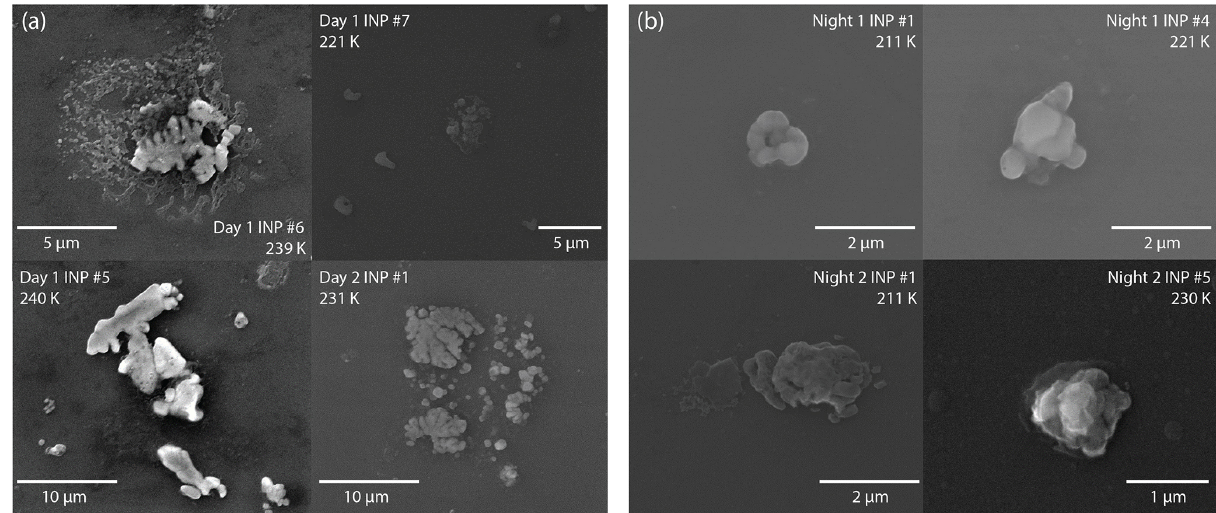
Figure 5. Exemplary electron micrographs of identified ice-nucleating particles (INPs) for daytime particle samples (a) and nighttime particle samples (b) . INP numbers refer to INPs shown in Fig. 6. The observed ice formation temperature is given for each